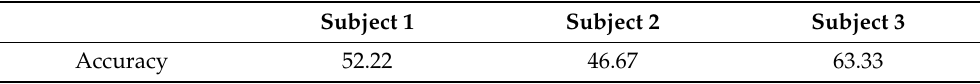
Table 1. Accuracy results of trial